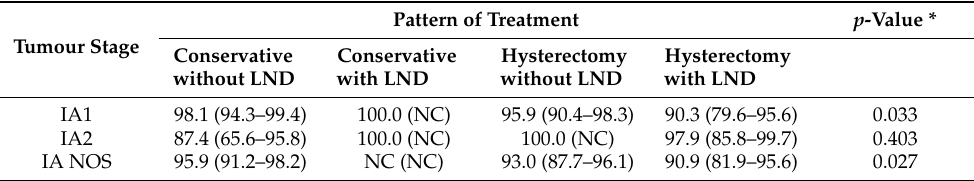
Table 5. Five-year overall percent survival (with 95% confidence interval) of registered patients with stage IA cervical carcinoma, by tumour stage and pattern of treatment. Emilia-Romagna Region, Italy (1995–2016). Pattern of Treatment p -Value * Tumour Stage Conservative Conservative Hysterectomy Hysterectomy without LND with LND without LND with